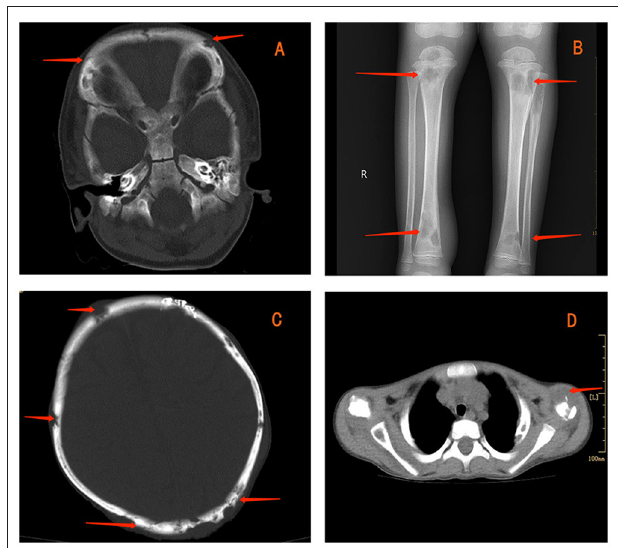
FIGURE 1 | Contrast - enhanced computed tomography (CT) showing multiple lytic bone lesions in the skull (A) . Radiography reveals multiple lytic bone lesions in bilateral tibias (B) . CT indicates osteolytic lesions in the skull (C) and left clavicle (D)